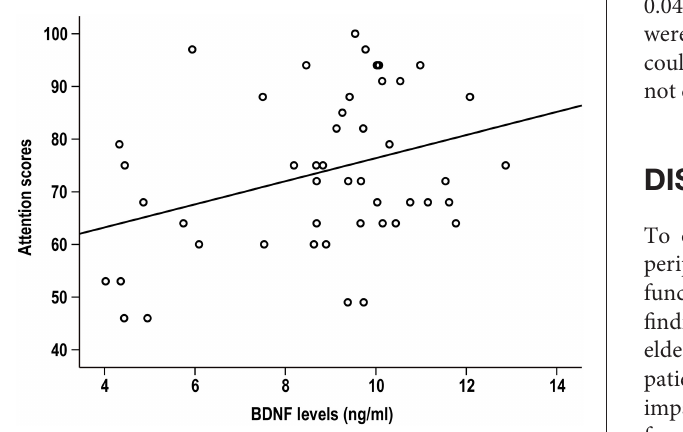
LLS patients exhibited poorer cognitive performance in terms of immediate memory, attention, language, delayed memory, and total scores of RBANS compared to healthy elderly